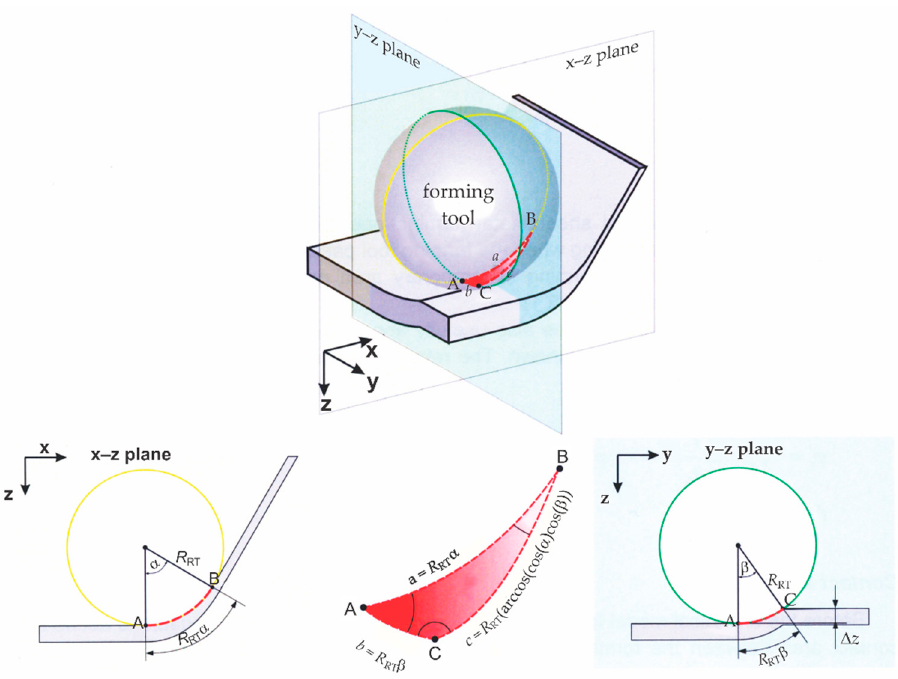
Figure 2. Determination of contact area during the SPIF process using spherical geometry [79]. Table 2. The results for the inner angle of spherical triangle β and side of spherical triangle b obtained from Equations (1) and (2).